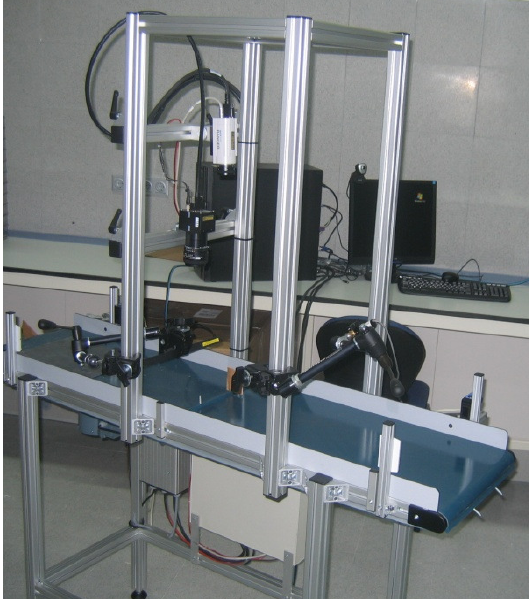
Figure 5. Prototype automated slate slab classification system.